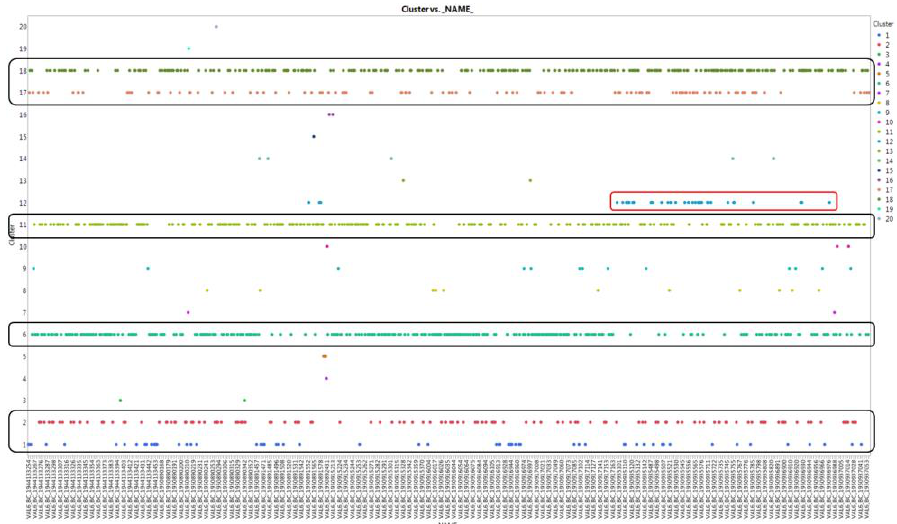
Figure 5. Cluster type by time stream for shaping pressure.